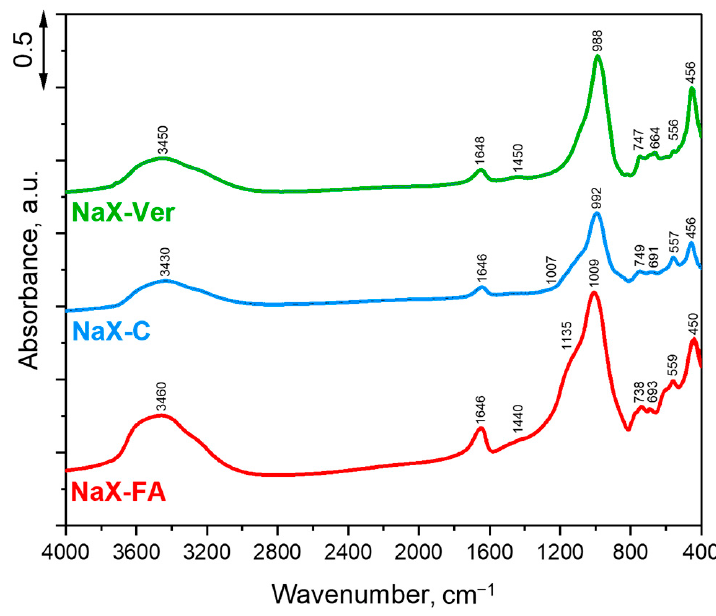
Figure 2. FTIR spectra of investigated